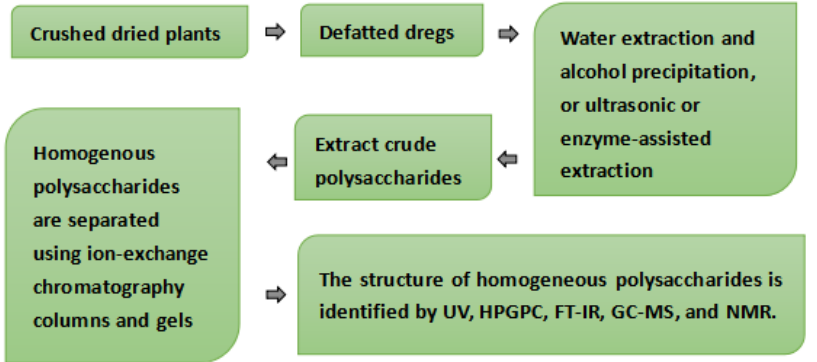
Figure 7. Extraction, isolation, and characterization of polysaccharides found in edible and medicinal plants in Xinjiang. Table 3. Extraction and isolation methods of five plant polysaccharides.